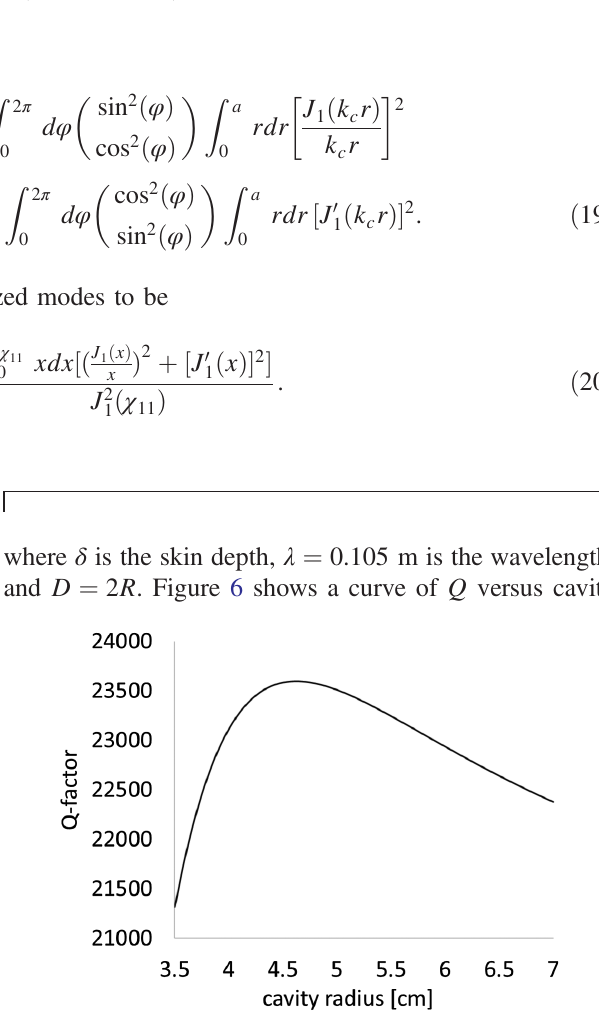
FIG. 6. Quality factor vs radius for TE 111 copper cavities resonant at 2.856 GHz. Realistic cavities, with beam and coupling apertures, will have lower